Question: State the chart type depicted above.
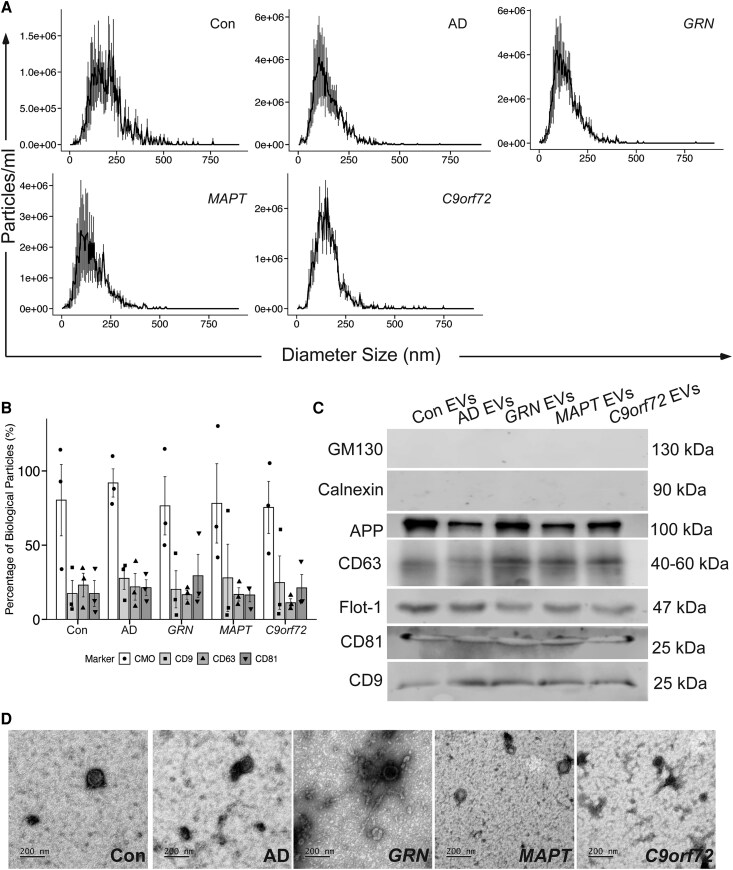
Answer: bar